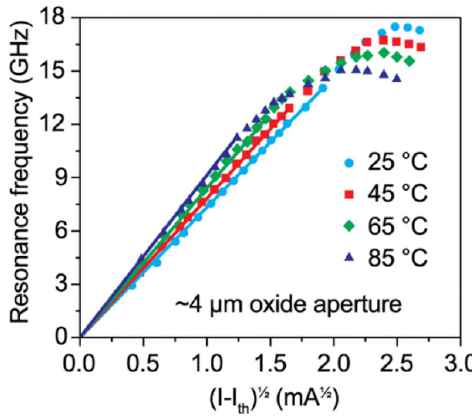
Figure 8. Relaxation resonance frequency versus square root of bias current minus threshold current for an approximate 4.0 μ m oxide ‐ aperture diameter VCSEL at 25, 45, 65, and 85 °C